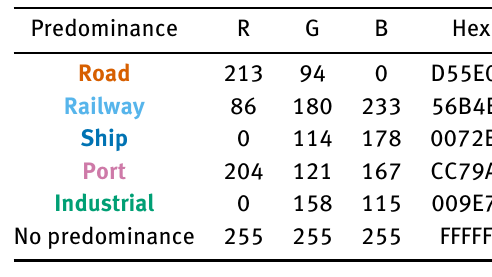
Table 2: Color Blindness optimized colors for macro-categories, from [49].